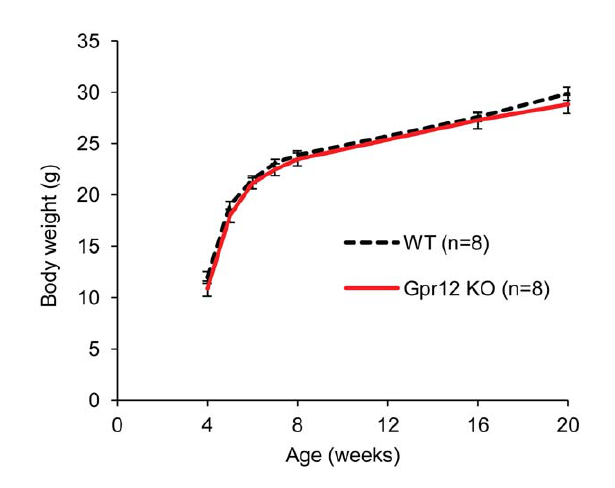
Figure 1. Body weight gain on lab chow. Body weight development in Gpr12 knockout (KO; n=8) mice (red line) and wildtype (WT; n=8) mice (dotted line) showed no difference at any measured time point.